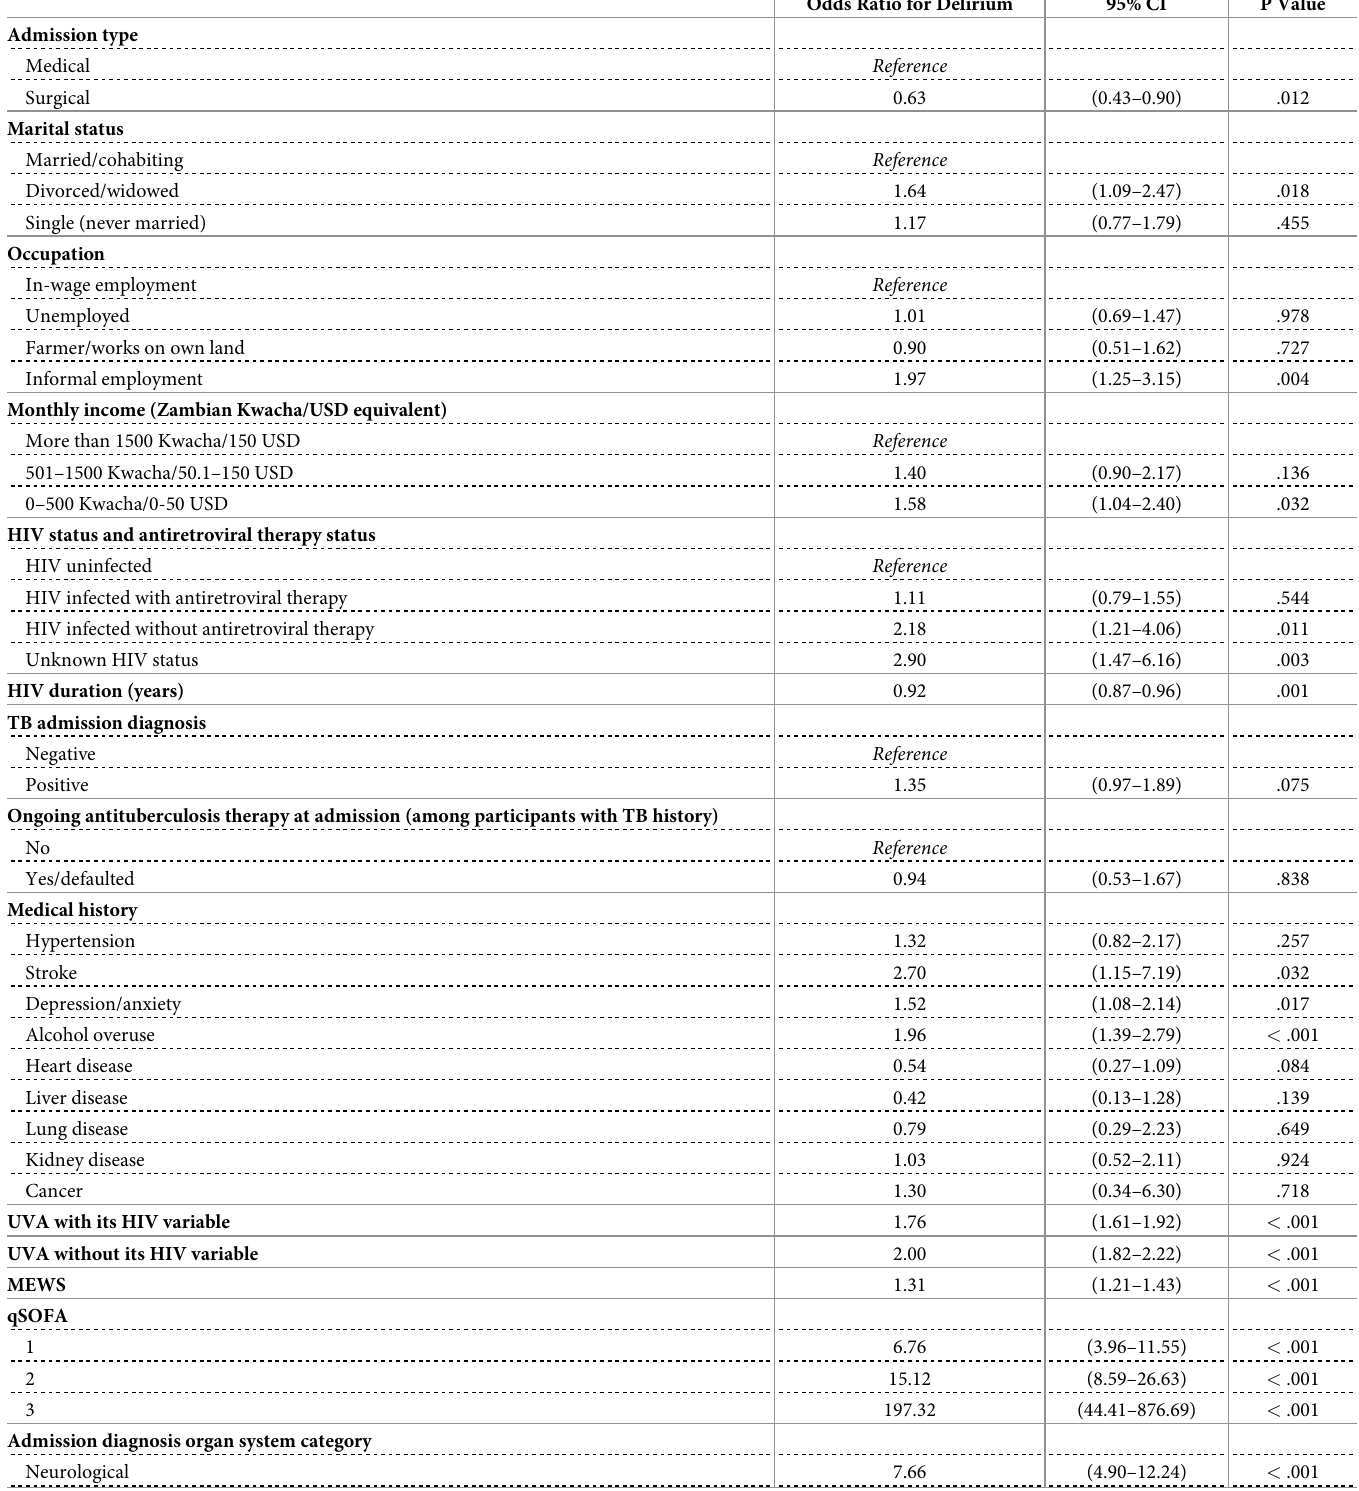
Table 2. Individual regression analyses of exposure variables a